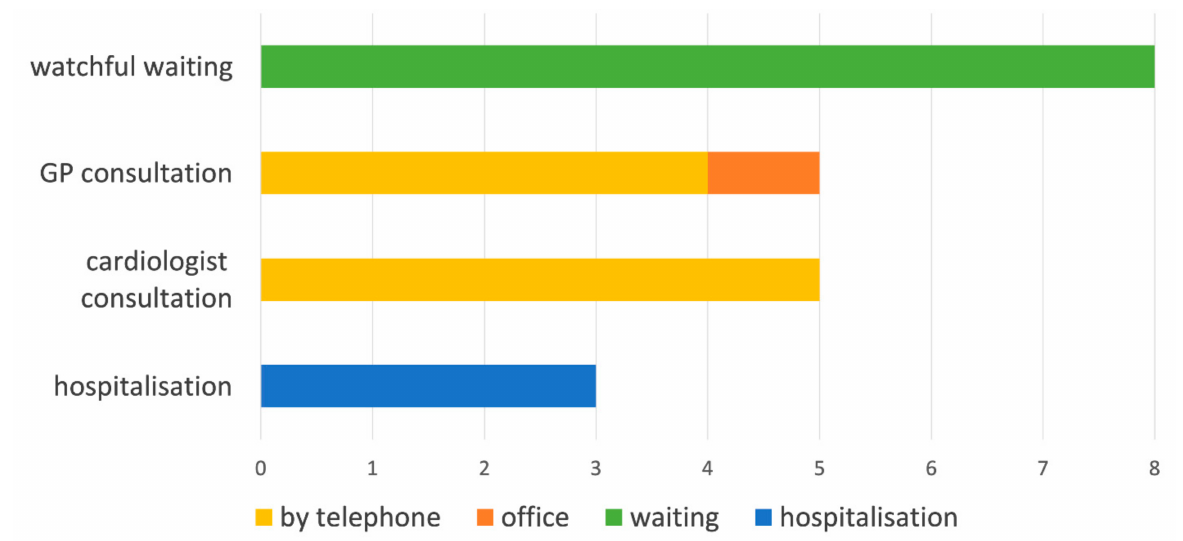
Figure 1. Decision to contact healthcare professional in the symptomatic